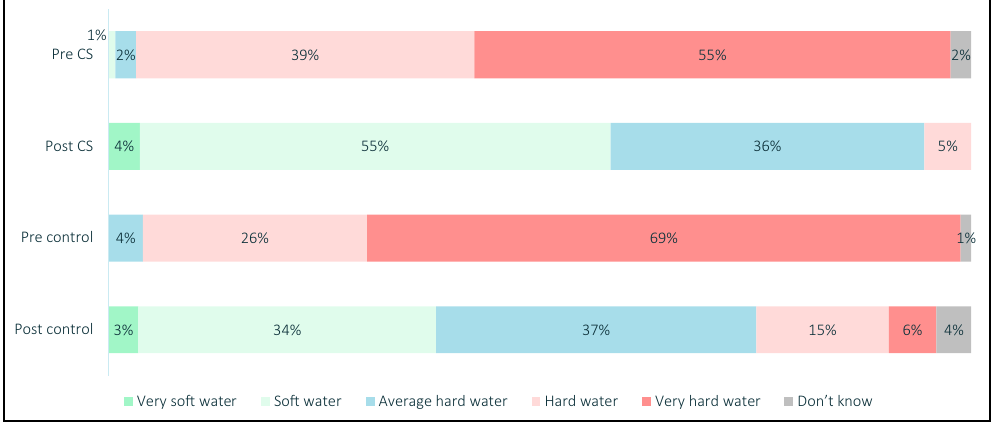
Figure 5 Perceived hardness of